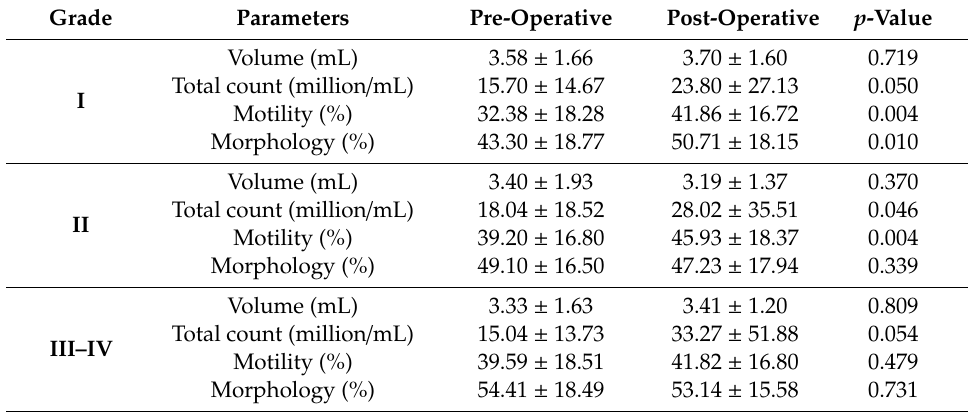
Table 4. Semen parameters pre- and post-varicocelectomy according to the grade of the